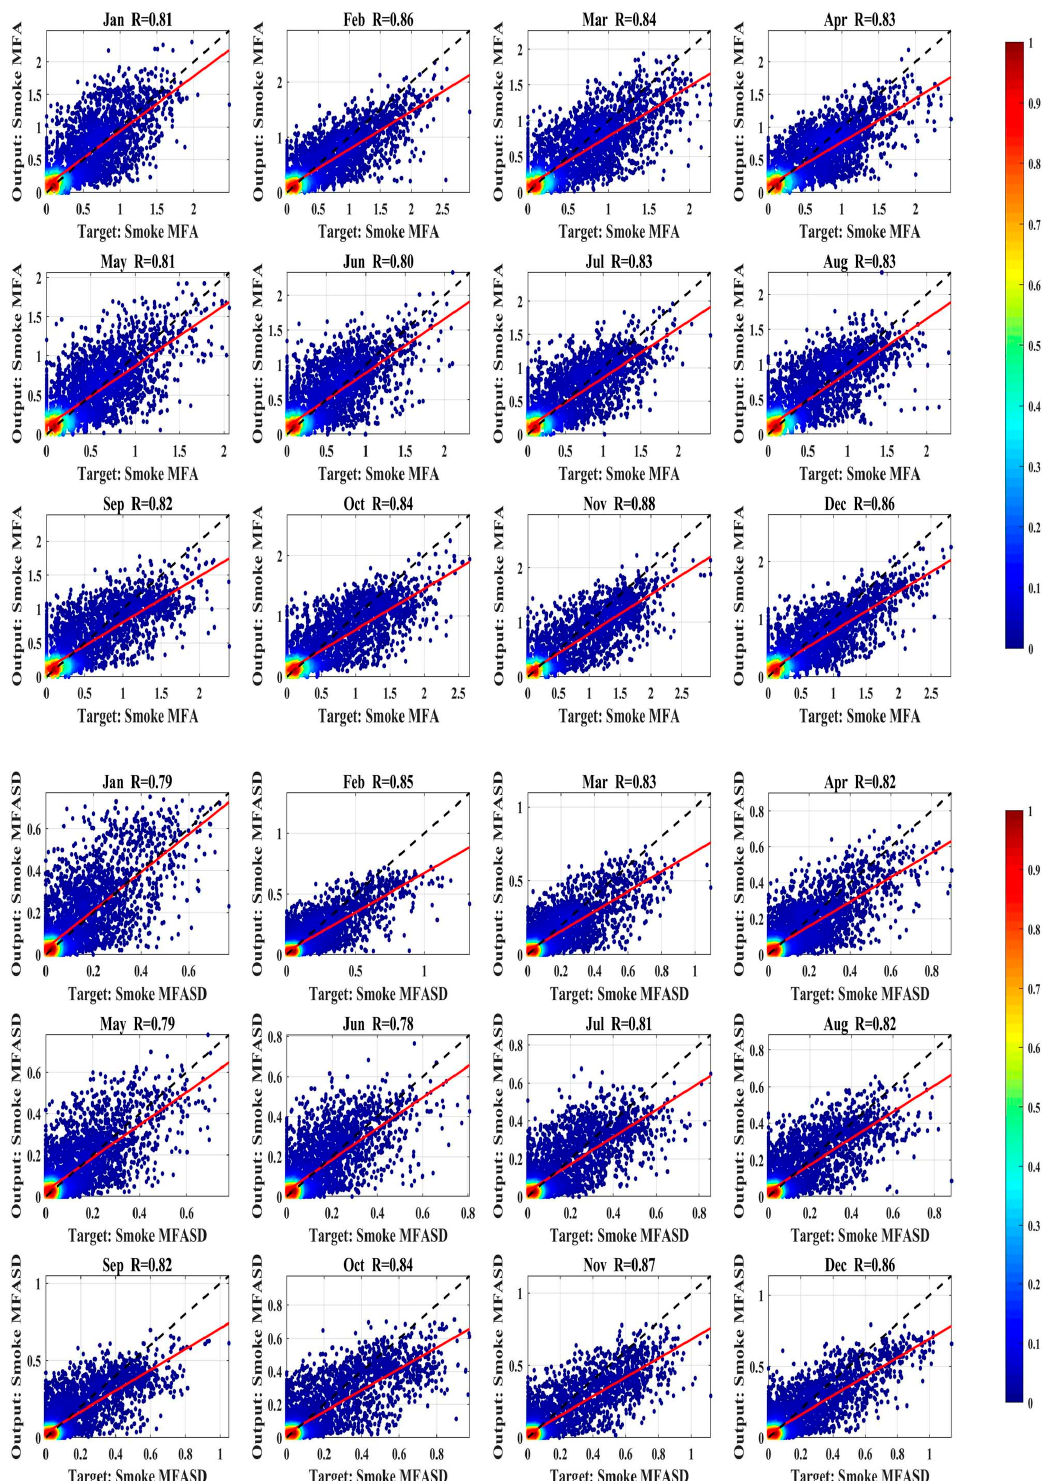
Figure 13. Correlation coefficients between model predicted and CALIPSO observed values of smoke aerosol MFA (km) and MFASD (km) in different months.